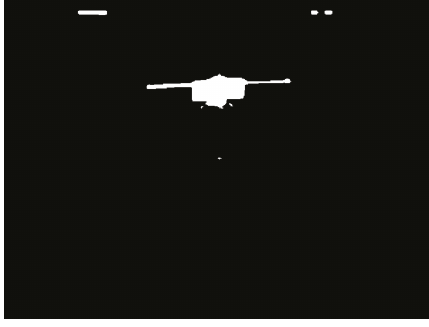
Figure 11: Binary image from the video shot during the